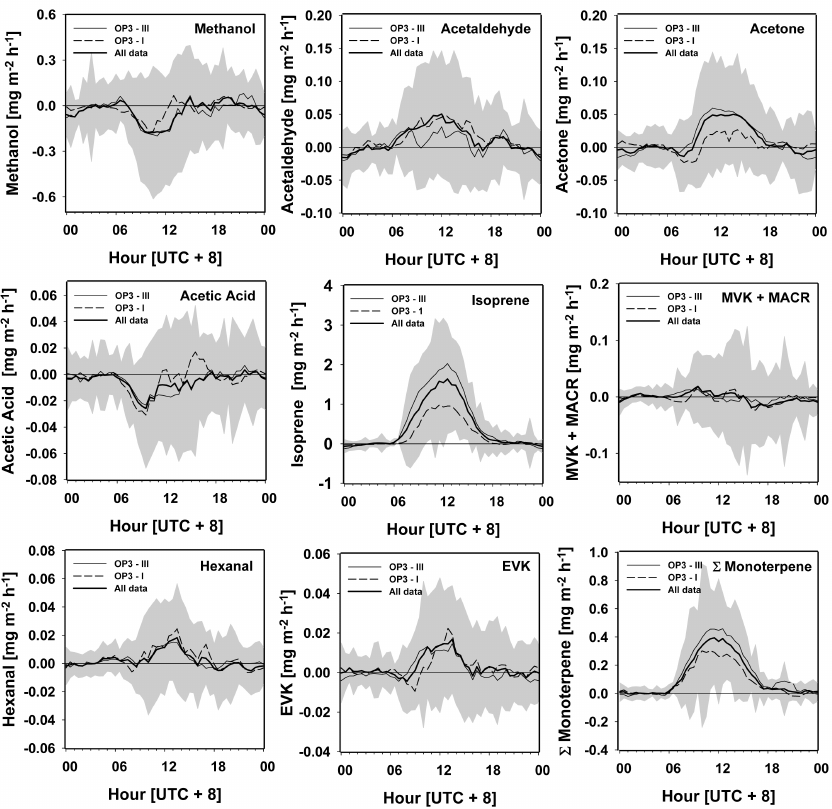
Fig. 10. Average diurnal profiles of VOC fluxes measured during the two intensive OP3 field campaigns which took place between 20 April– 7 May (OP3-I) and 20 June and 20 July (OP3-III), 2008. Greyed bands show ± 1 standard deviation of averaged hourly